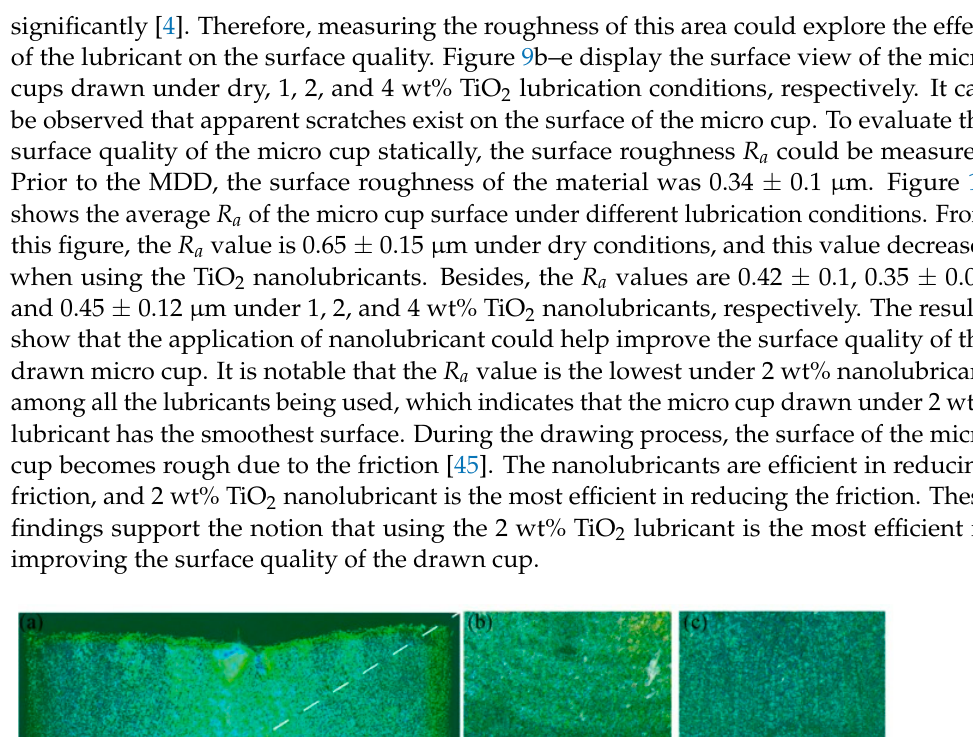
Figure 8. Mouth view of drawn cups from different lubrication conditions: ( a ) dry; ( b ) 1 wt% TiO 2 lubrication; ( c ) 2 wt% TiO 2 lubrication; and ( d ) 4 wt% TiO 2 lubrication.